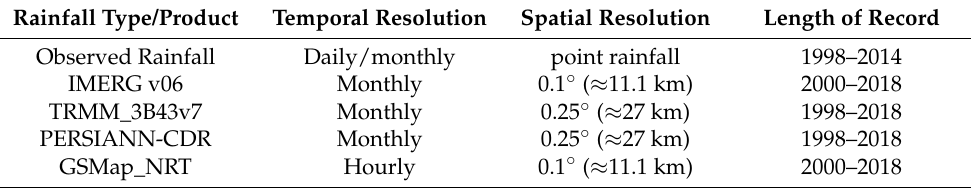
Table 1. Summary of the climatic data used in this study. Rainfall Type/Product Temporal